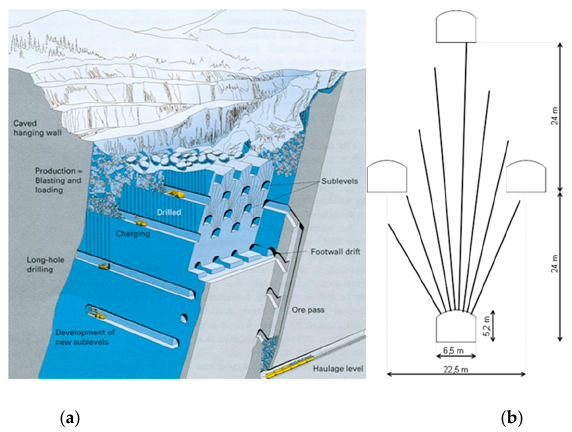
Figure 2. ( a ) Sublevel caving mining (courtesy by Atlas Copco); and ( b ) an example of a fan used in the Malmberget mine.